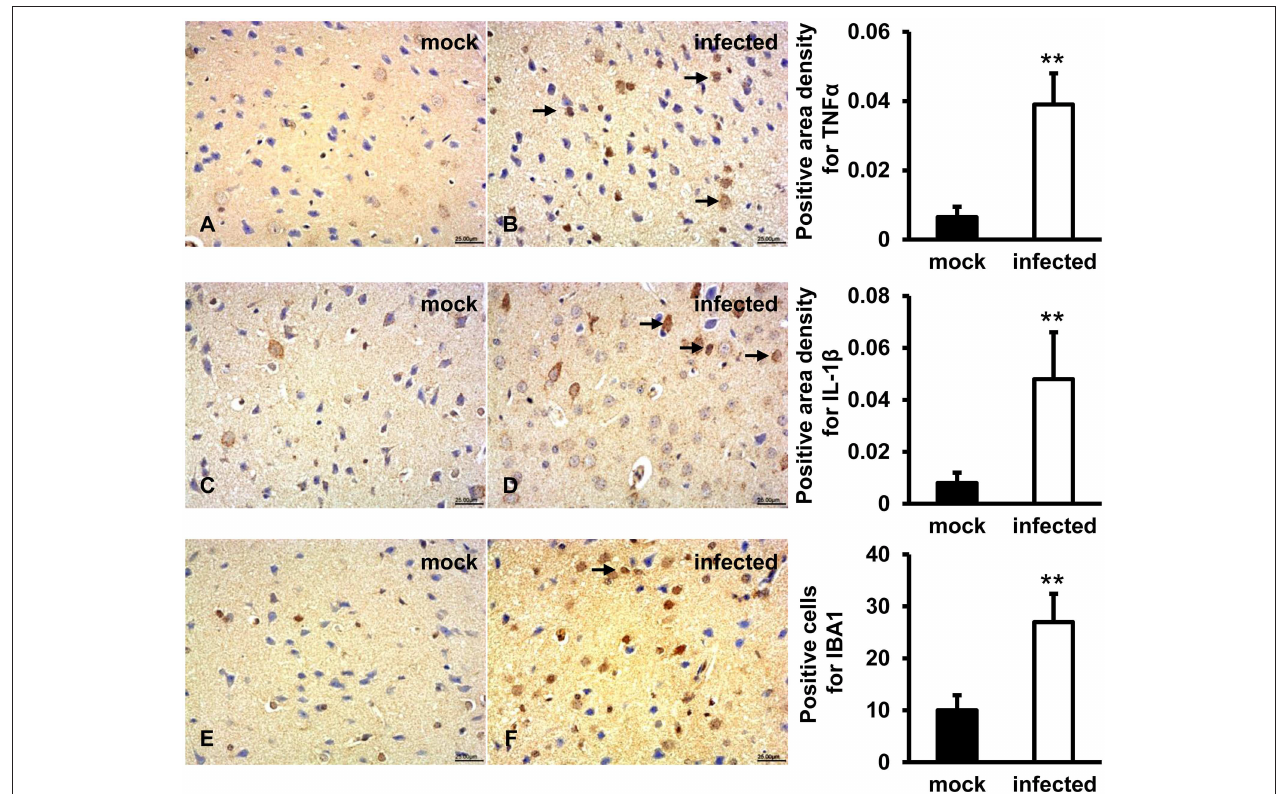
FIGURE 6 | Increased pro-inflammatory responses were examined in HEV infected animal brain tissues. HEV-RNA positive brain tissues collected on 14, 21, and 28 dpi were used for immunohistochemistry study of TNF α (rabbit polyclonal IgG), IL-1 β (rabbit polyclonal IgG), and IBA1 (rabbit polyclonal IgG). Goat anti-rabbit IgG was chosen as secondary antibody. The positive signal was measured via the Motic Med 6.0 CMIAS Image Analysis System. (A,B) Positive signal of TNF α was diffusely observed in a large number of microglial cells, astrocytes and few pyramidal neurons in HEV infected animal brain tissues, and expression level was significantly induced compared with mock group (** p < 0.01). (C,D) The expression level of activated IL-1 β was found in microglia, astrocytes, and few neuronal cytoplasms and was significantly increased in HEV infected brain sections compared with tissues from mock group (** p < 0.01). (E,F) Positive expression of IBA1 was detected in microglial cells with significantly elevated levels in brain tissues infected with HEV compared with mock group (** p < 0.01).